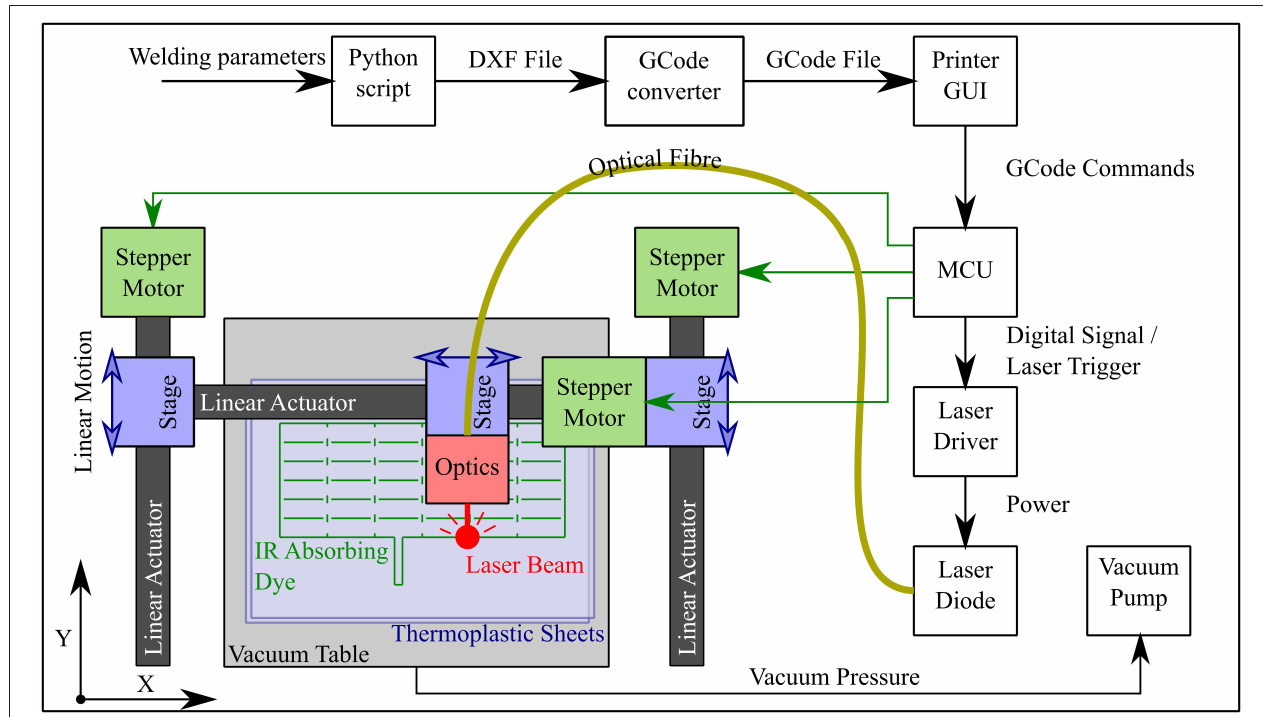
FIGURE 3 | Workflow and schematic of laser welding system showing the progression from the welding parameters input by the user to gcode commands interpreted by the microcontroller (MCU), which controls not only the motion of the optics but also the triggering of the laser diode. The Cartesian robot constitutes three linear actuators whose stages are driven by belts and timing pulleys coupled to stepper motors.